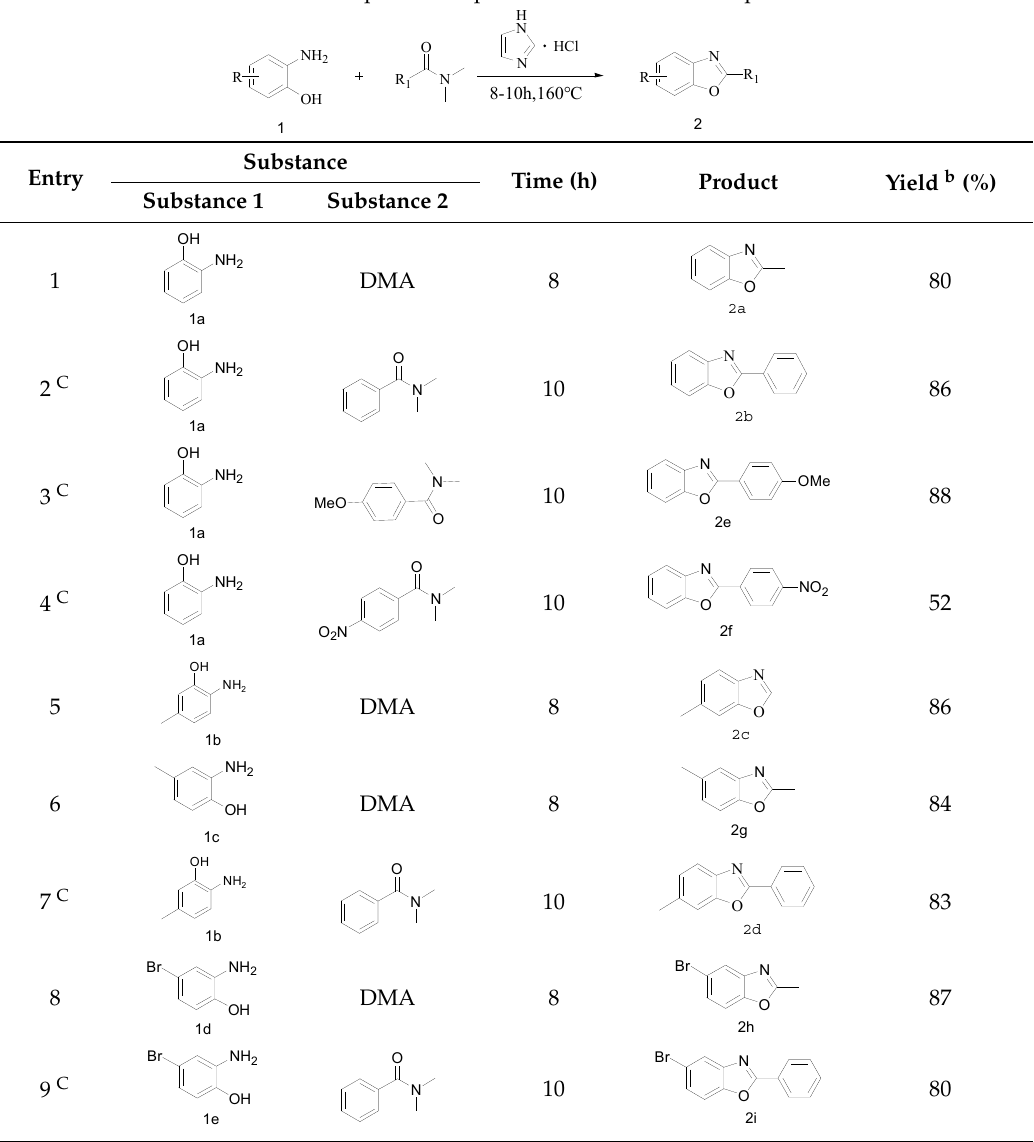
Table 3. Substrate scope with respect to substituted 2-aminophenols a .